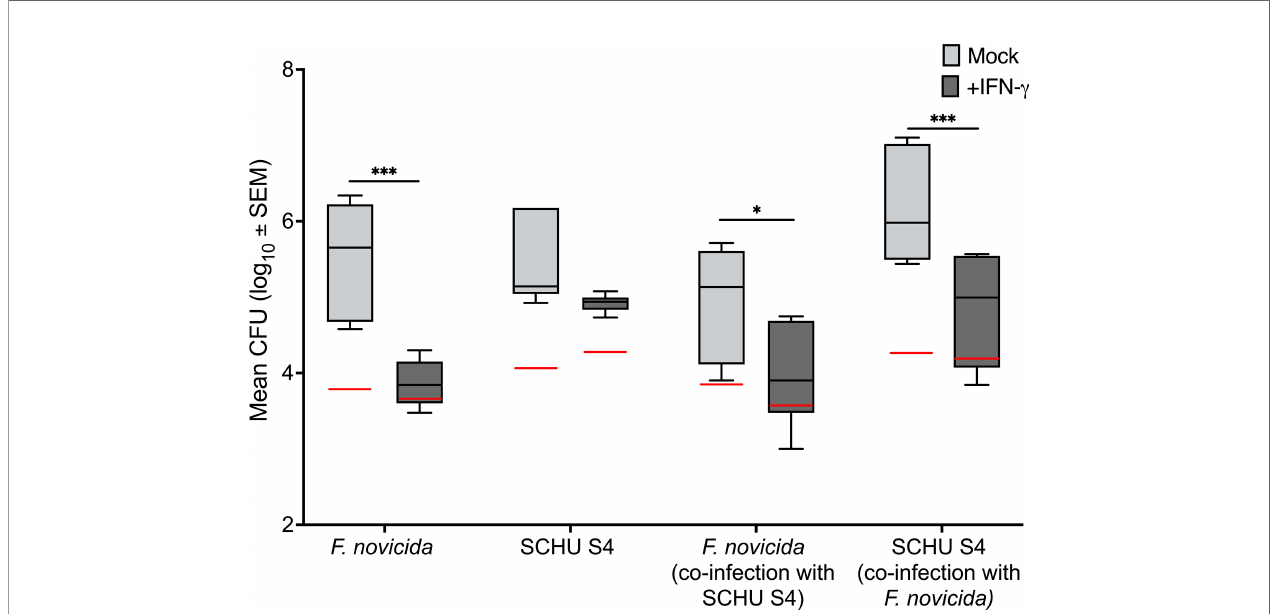
FIGURE 6 | Intracellular replication of F. novicida and SCHU S4 in a co-infection model. BMDM were infected with either F. novicida or SCHU S4 using an MOI of 100, or both strains in the presence or absence of IFN- g . * P < 0.05, *** P < 0.001. Red lines indicate the